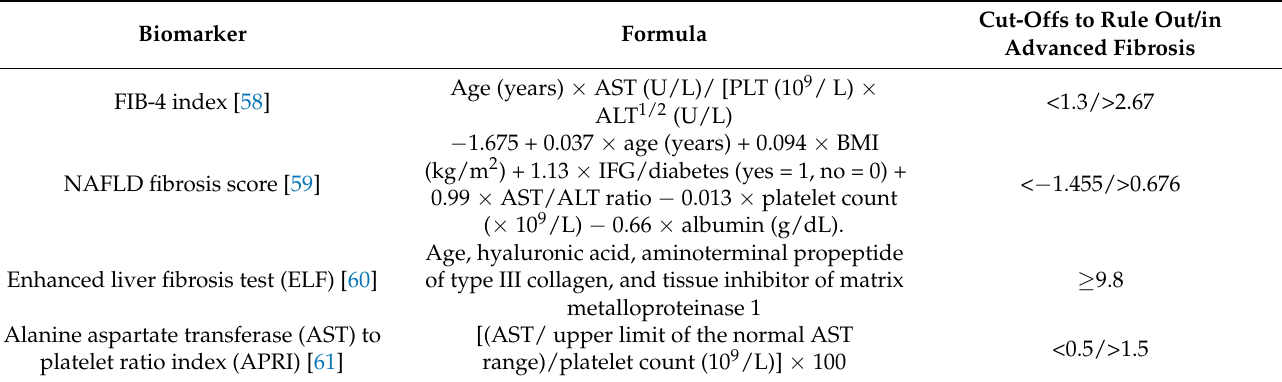
Table 3. Biomarkers for fibrosis